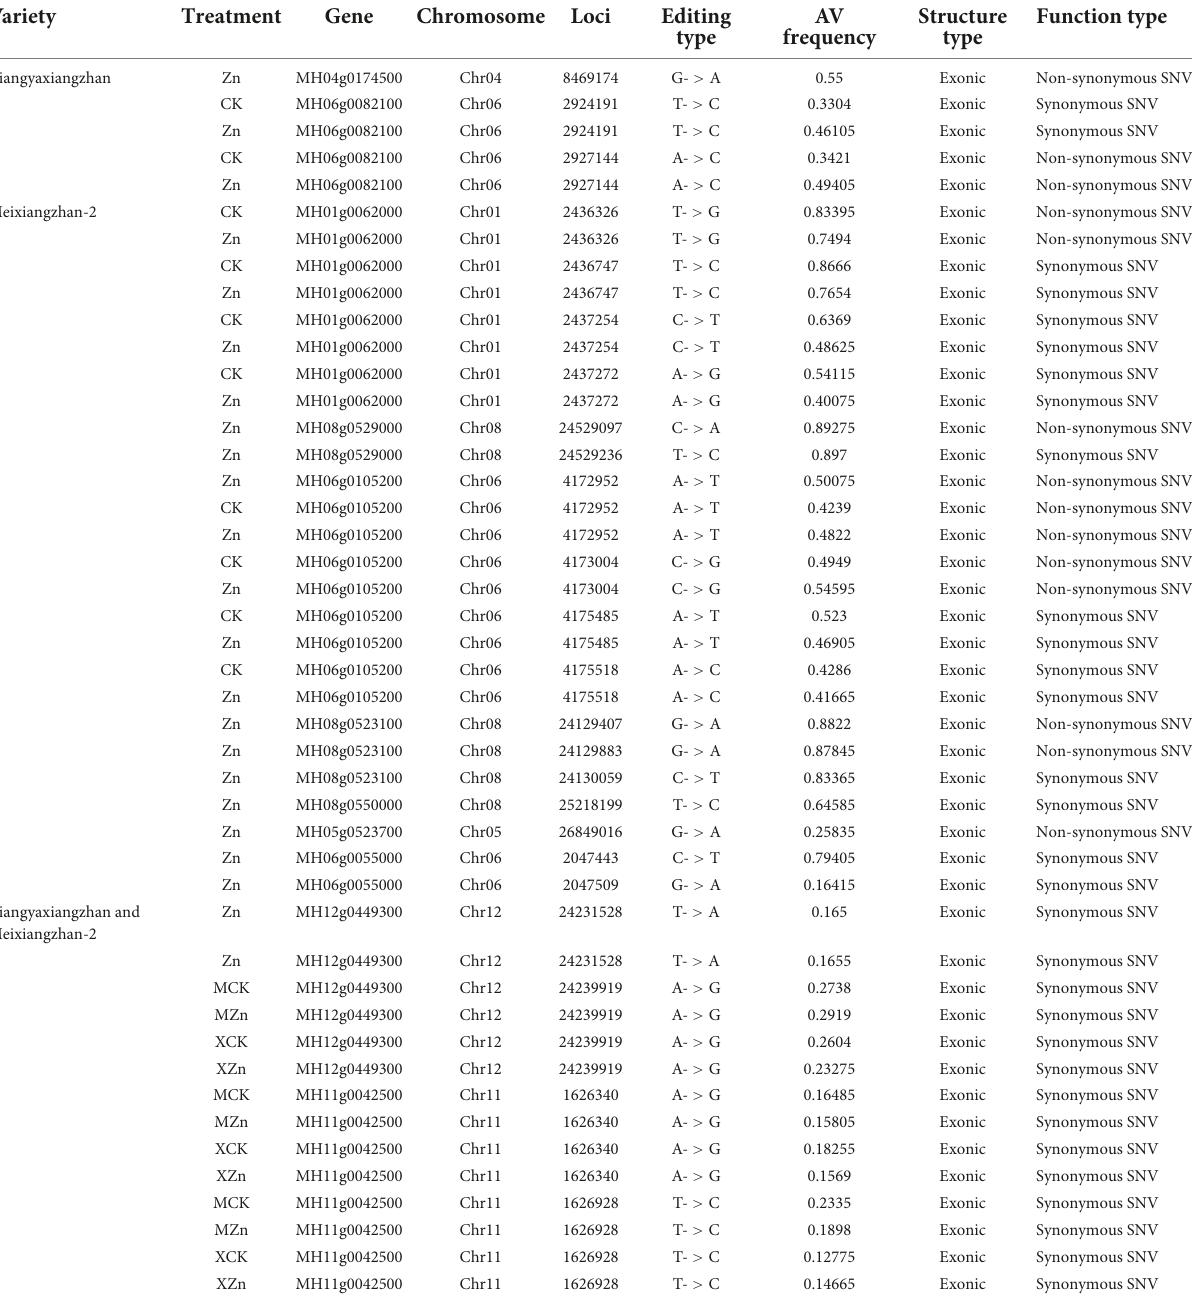
TABLE 1 Summary of SNPs in the genes related to the 2-AP biosynthesis pathway in Meixiangzhan-2 and Xiangyaxiangzhan cultivars in response to Zn treatment.